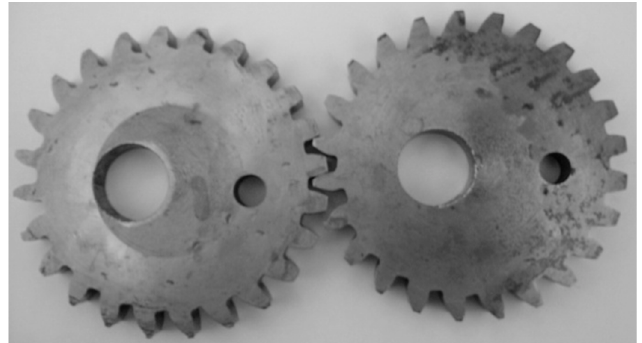
Figure 1. Model of the gear set.